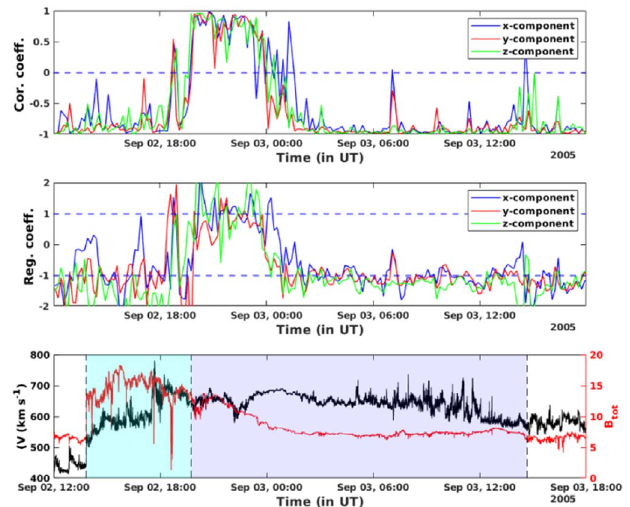
Figure 5. The correlation and regression coef fi cients are shown in the top two panels, while the variations of total magnetic fi eld ( B tot ) and the solar wind speed ( V ) with time are shown in the bottom panel.